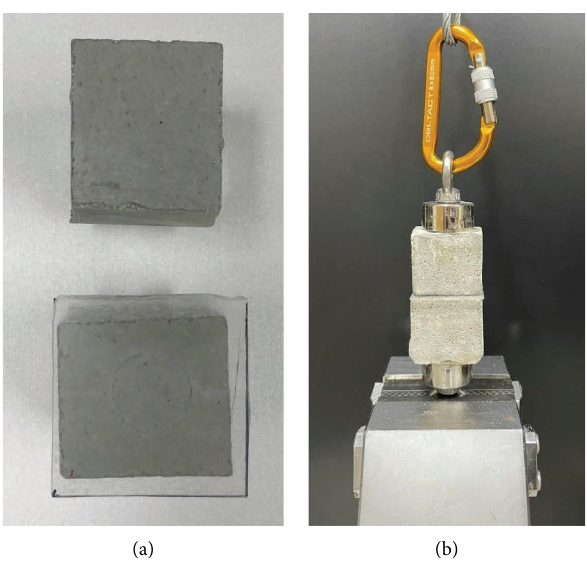
Figure 2: Adhesion test: (a) specimens and (b) test